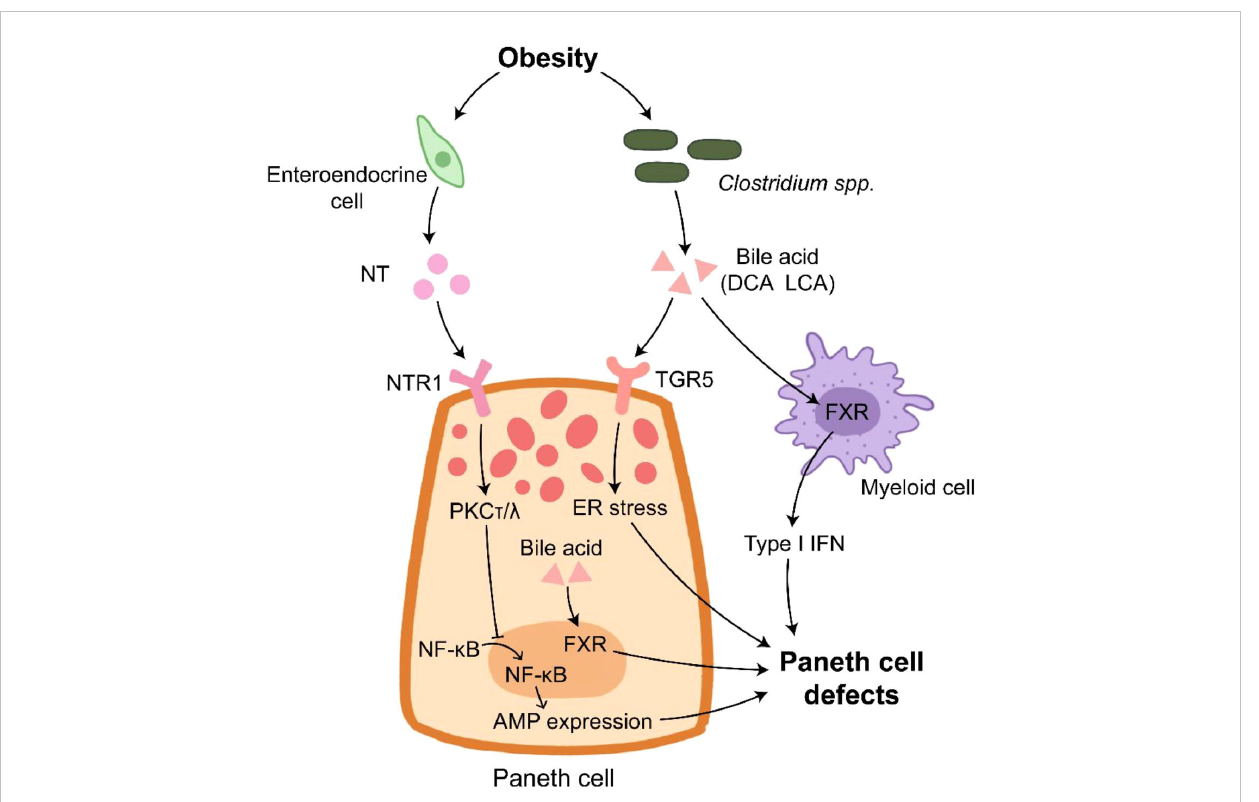
FIGURE 2 Paneth cells in obesity. Paneth cell disruption in obese individual is under multiple control. NT derived from enteroendocrine cells inhibits AMP expression through inducing PKC t / l that suppresses the translocation of NF- k B into nucleus. The elevated bile acid provided by Clostridium spp. binds to TGR5 to induce ER stress in Paneth cells. In addition, bile acid activates FXR in Paneth cells and myeloid cells, which results in Paneth cell